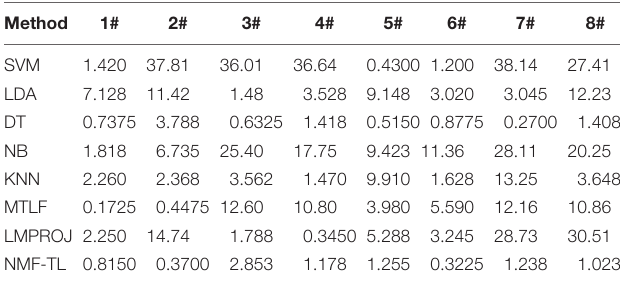
TABLE 12 | Friedman values for 8 different methods on datasets based on WPD feature extraction.